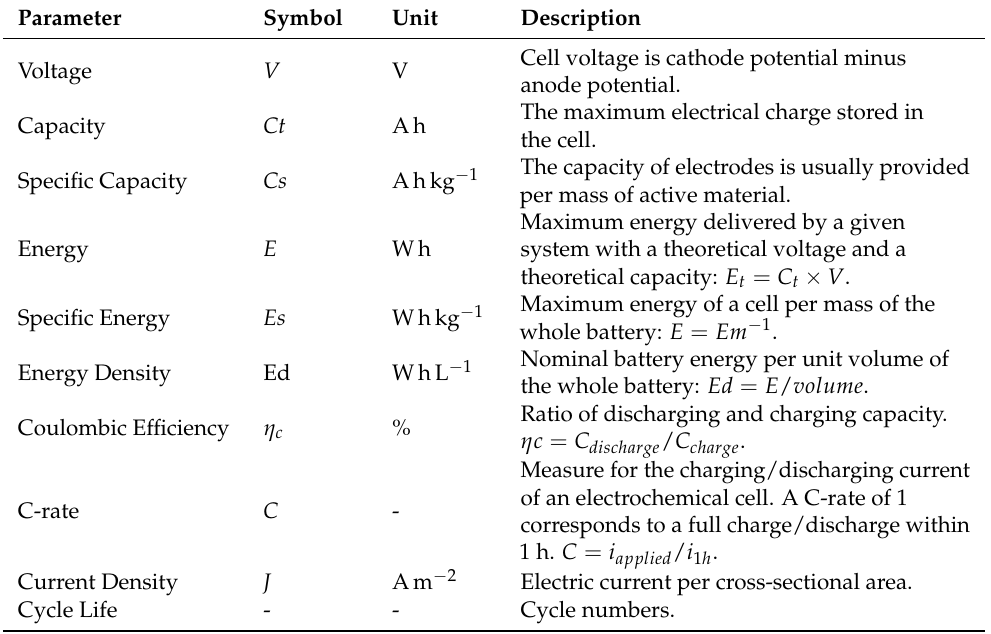
Table 1. Selected electrical parameters of batteries